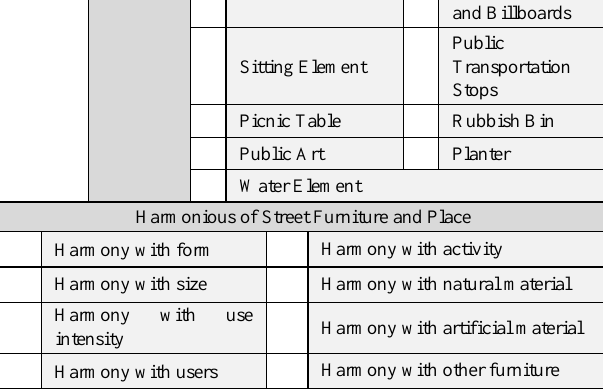
Figure 2. Street Furniture Identification Card on KTU Kanuni